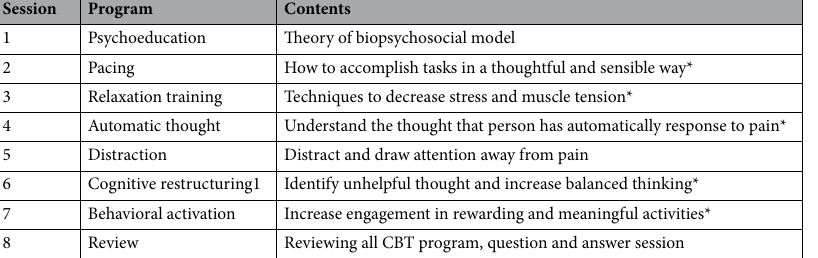
Table 2. Protocol of CBT. *Including